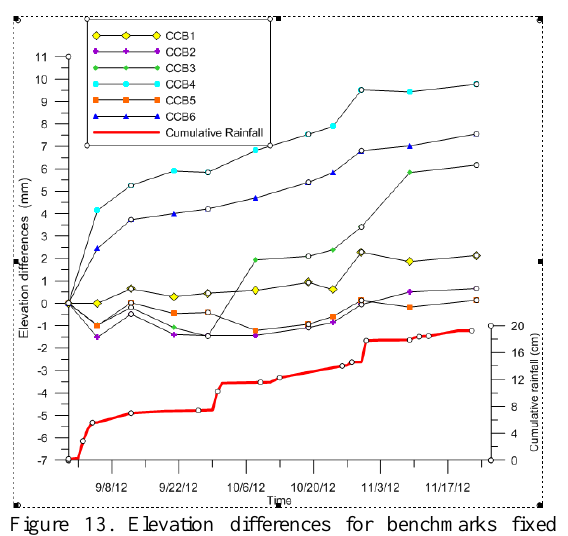
Figure 13. Elevation differences for benchmarks fixed in concrete casting over soil with respect to first